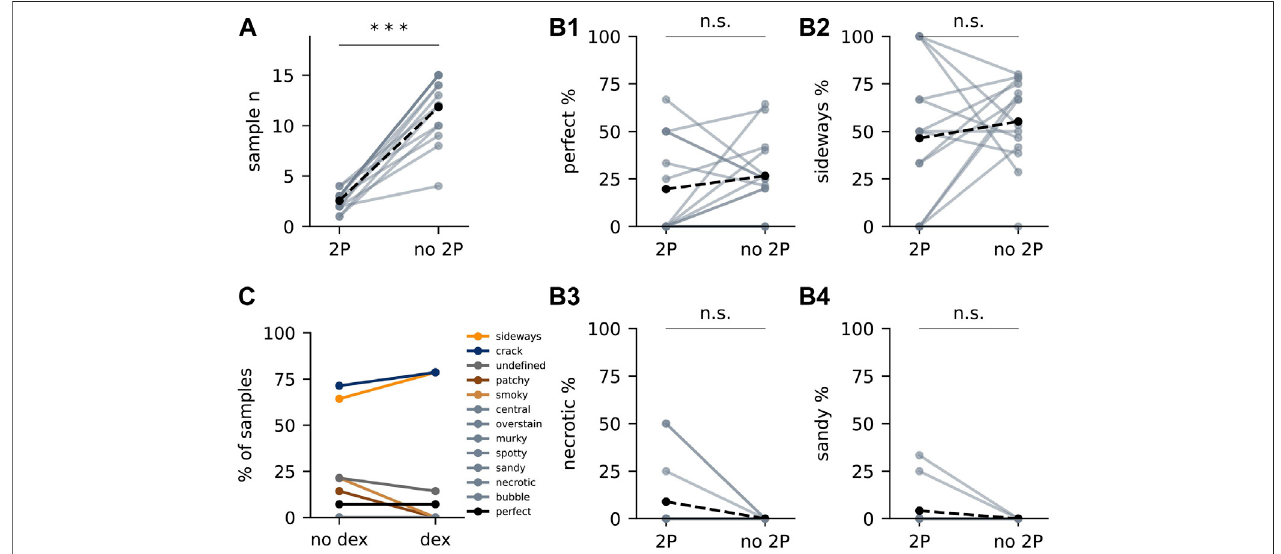
FIGURE4| The effect of 2P and dexamethasone on artefact occurrence. (A) Number of samples with ( “ 2P ” ) and without in vivo functional imaging ( “ no 2P ” ) from each experiment. Each light dot represents “ 2P ” samples or “ no 2P ” samples of one experiment. Solid lines connect “ 2P ” samples to “ no 2P ” samples from the same experiment. Black dots represent the mean. Dashed lines connect the mean values. Asterisks represent statistical signi fi cance (***: p < 0.0005, two-tailed paired t -test). (B1) Percentage of perfect samples from each experiment. (B2 – B4) Percentage of samples with “ sideways ” (B2) , “ necrotic ” (B3) and “ sandy ” (B4) . (C) Artefacts in samples administered with and without dexamethasone within the same experiment ( n = 13 and 14, respectively).